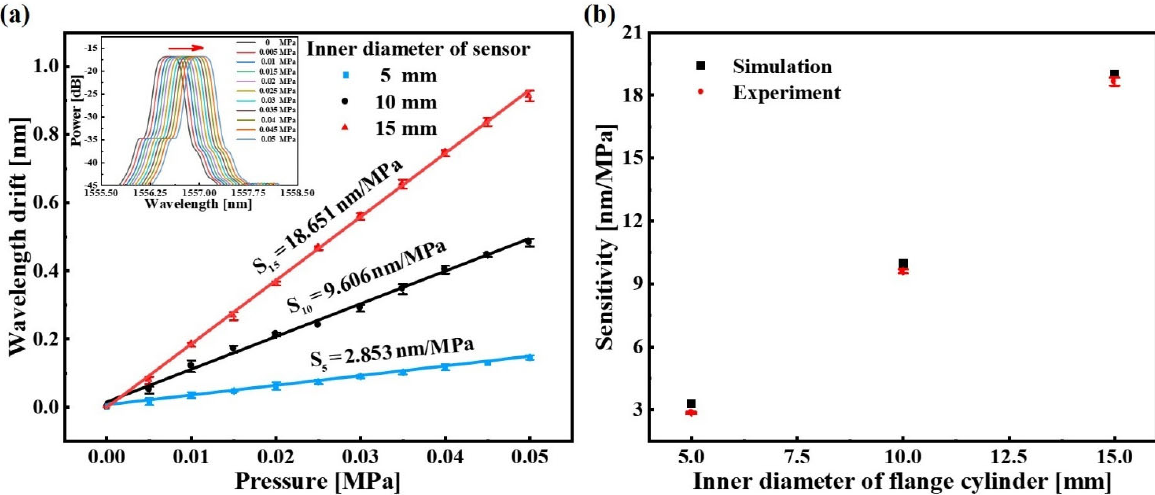
Figure 5. Experiment: ( a ) schematic diagram of the sensor testing system; ( b ) experimental setup. The performances of the sensors with 5 mm, 10 mm and 15 mm inner diameter in the measurement range of 0 m to 5 m water level were tested, respectively. At a constant water temperature of 26 °C, the water level was increased from 0 m to 5 m at steps of 0.5 m. For